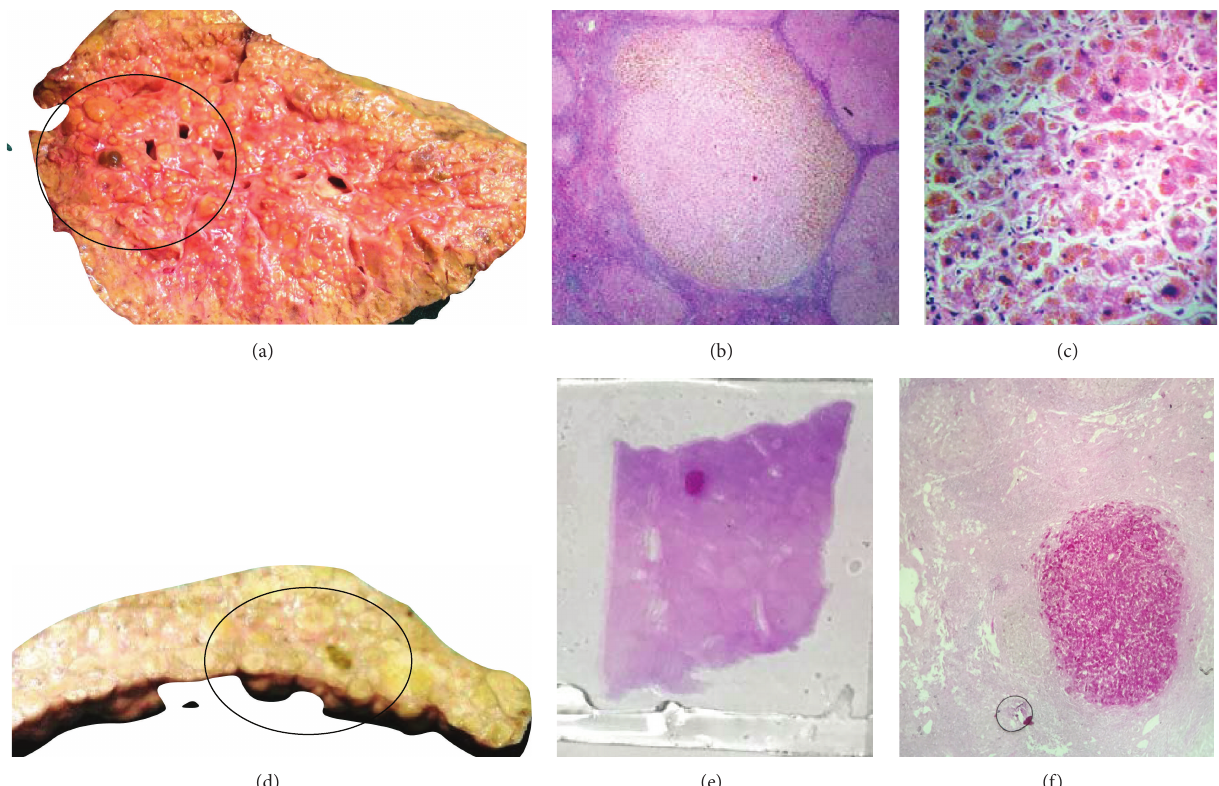
Figure 4: (a) Necrotic nodule in explant liver (b and c). Photomicrograph showing all degenerated hepatocytes in low and high power (H&E × 10 and 40). (d) Necrotic nodule in explant liver (e and f). Photomicrograph showing PAS positive staining of necrotic nodule in section and low